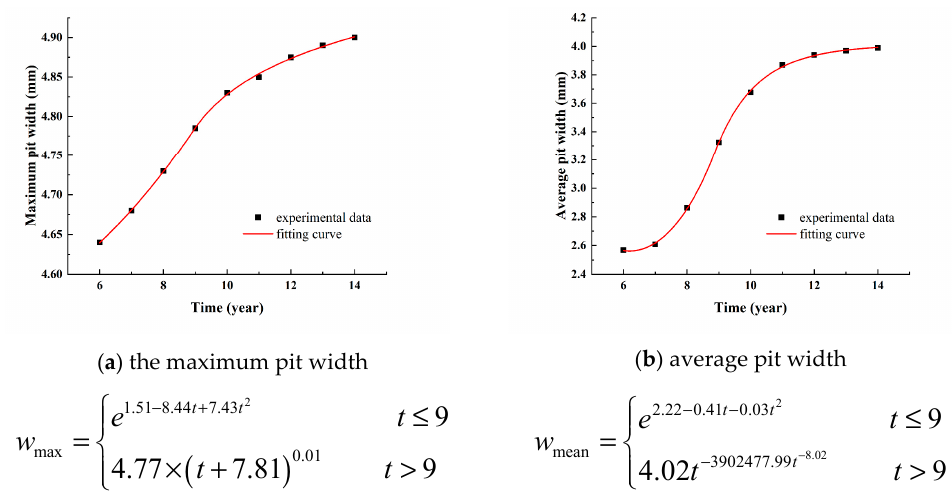
J. Mar. Sci. Eng. 2023 , 11 , x FOR PEER REVIEW